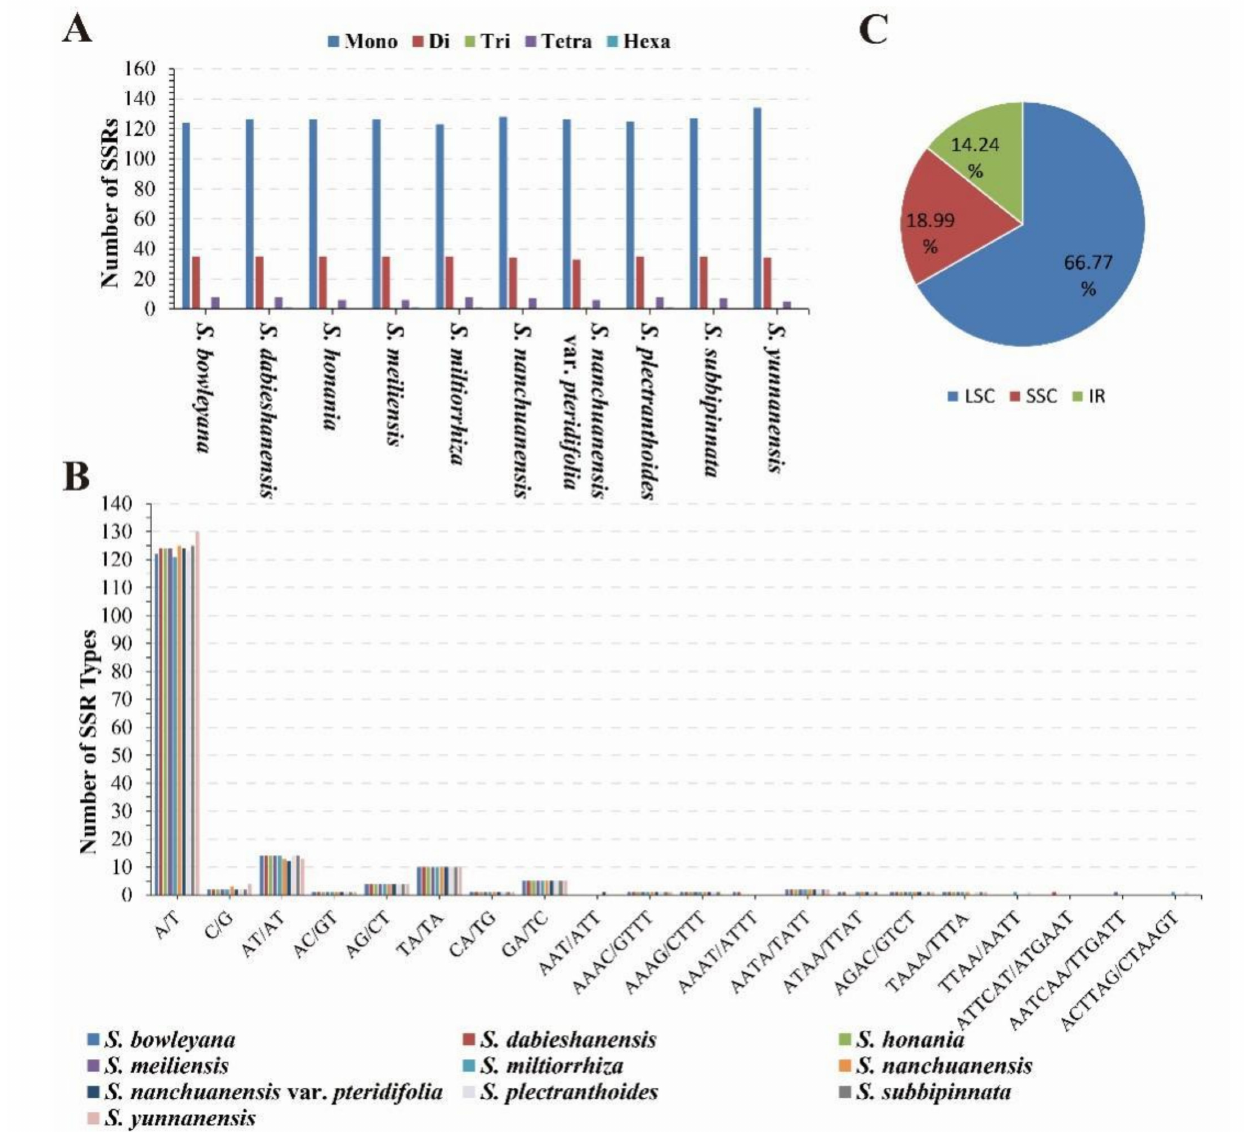
Figure 4. Comparison of simple sequence repeats (SSR) among the plastomes of 10 taxa of Salvia sect. Drymosphace . ( A ). Number of different types of SSRs; ( B ). number of different of SSR repeat units; ( C ) frequencies of SSRs in LSC, IR, and SSC